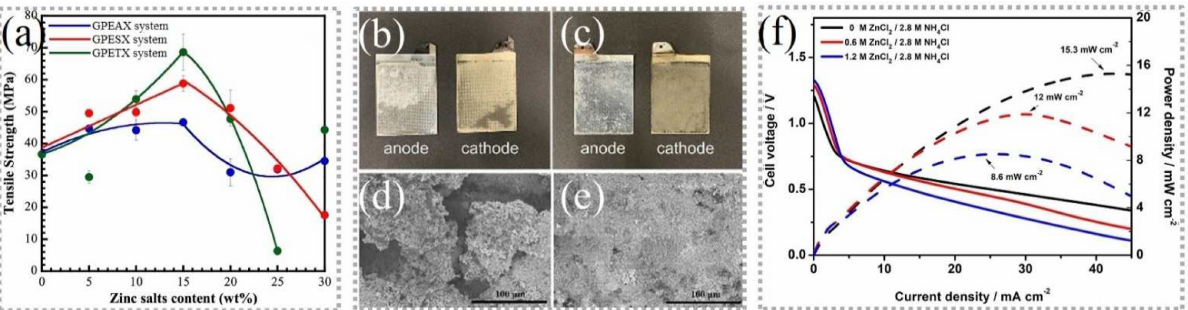
Figure 6. ( a ) Tensile strength of CMC with different zinc salts and concentration. (Blue) GPEAx system, (red) GPESx system, and (green) GPETx system. Adapted with permission from Ref. [49]. Copyright 2021 Scientific Reports. ( b ) After 368 h in KOH aqueous electrolytes and ( c ) 431 h in PAAK − KOH GPE. SEM image of Zn anode after standing for ( d ) 368 h in KOH aqueous electrolyte and ( e ) 431 h in PAAK − KOH GPE. Adapted with permission from Ref. [50]. Copyright 2022 ACS Applied Materials & Interfaces. ( f ) The galvanodynamic discharge curves and the corresponding power density plots of FZABs with the GPEs soaked in the electrolytes containing 2.8 M NH 4 Cl and (1) 0, (2) 0.6, and (3) 1.2 M ZnCl 2 . Adapted with permission from Ref. [51]. Copyright